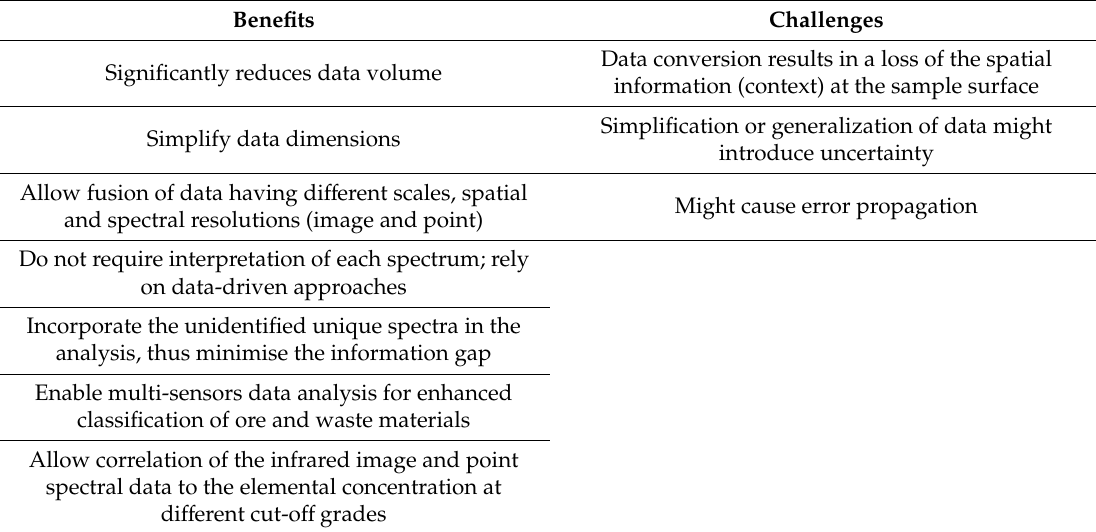
Table 6. The potential benefits and limitations of the proposed methodological